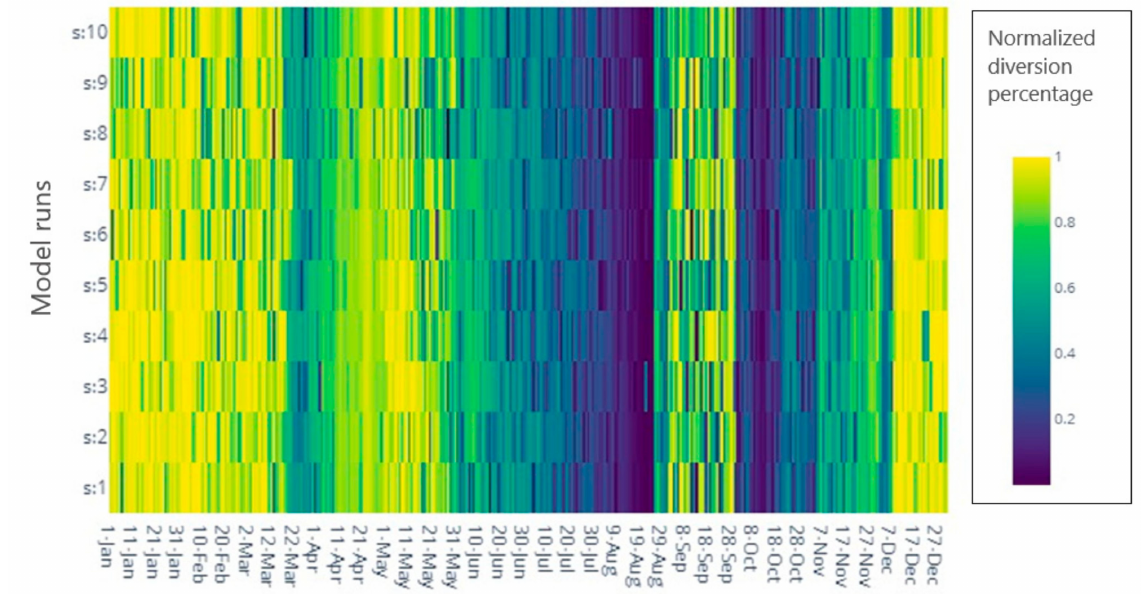
Figure 9. Comparison of the results for each run of the optimization model showing the pattern of the normalized average daily diversion percentage values (expressed as the daily percentage of the natural daily discharge). Yellow (1) tiles correspond with the highest daily percentage, whereas blue (0) tiles correspond with the lowest optimal daily diversion. Presented results are for the DP1 under the dry